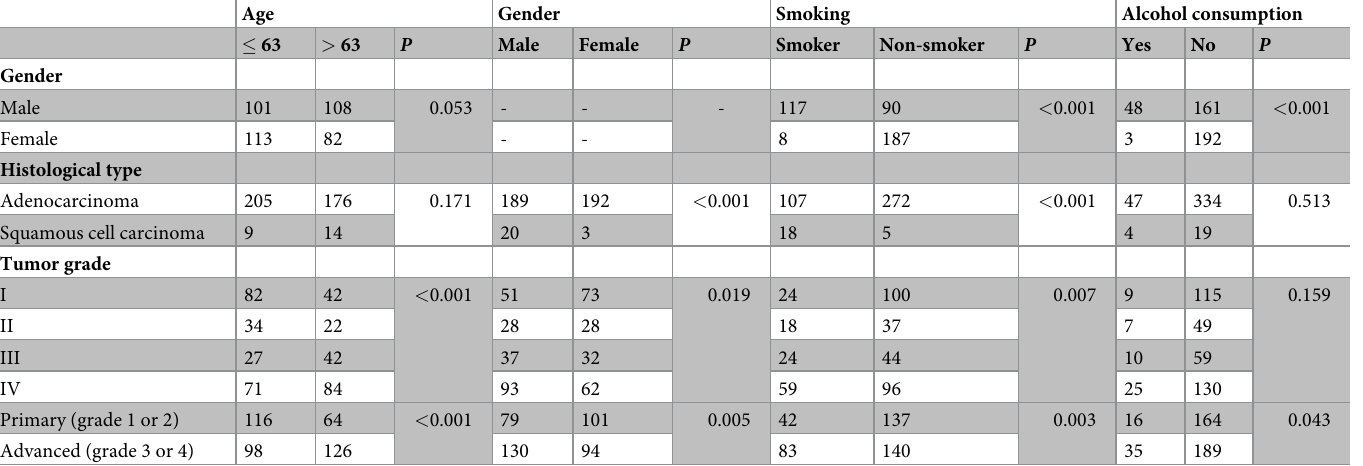
Table 5. Association between demographics of patients and tumor characteristics.